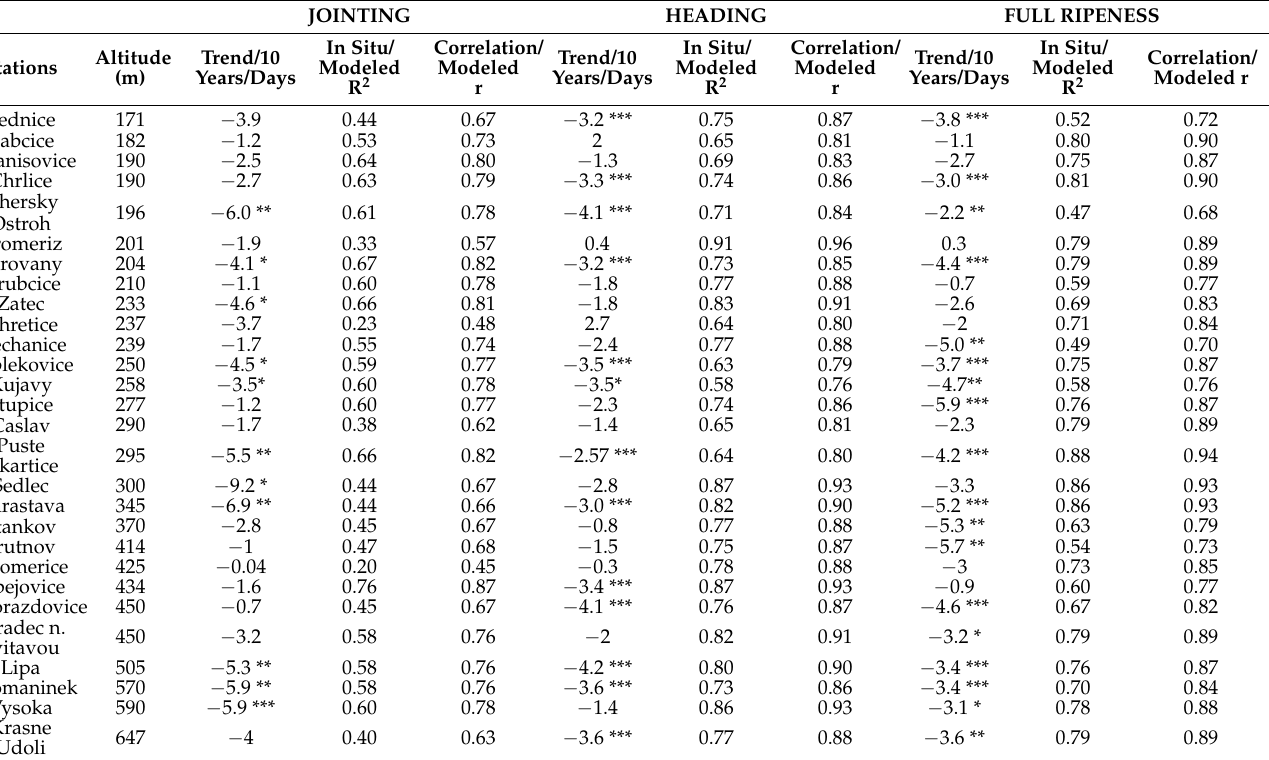
Table 2. Linear trends for observed jointing, heading, and ripening phenophases among the 28 ob- servation stations. Positive values of trends indicate a shift in the onsets of phenophases to a later date, and negative values indicate a shift to an earlier date. The values of the correlation coefficients describe the relationships among observed and modeled terms of the phenophases and, which were statistically significant in all cases. * Significant trend at α = 0.05; ** significant trend at α = 0.01; *** significant trend at α = 0.001.